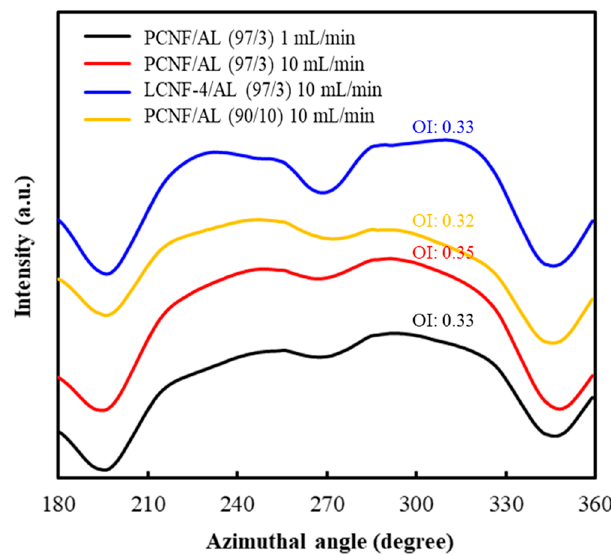
Figure 5. 2D XRD patterns of wet-spun composite filaments made of PCNF/AL and LCNF-4/AL with different AL contents and spinning rates.